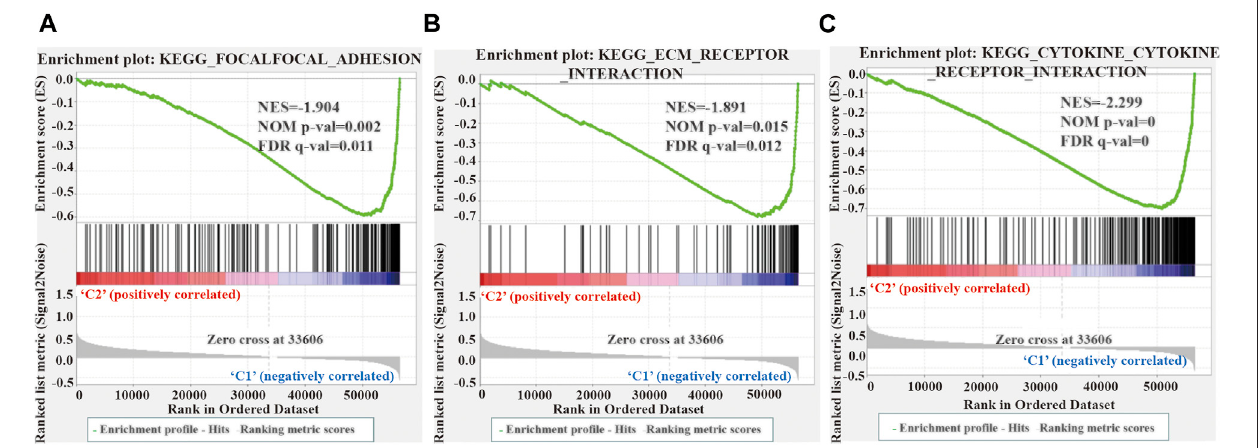
FIGURE 6 | Gene enrichment analysis (GSEA) among different two clusters. (A – C) GSEA shows that focal adhesion kinase (A) , extracellular matrix receptor interaction (B) , and cytokine receptor (C) are enriched in cluster 1 of LUSC. LUSC, lung squamous cell carcinoma.